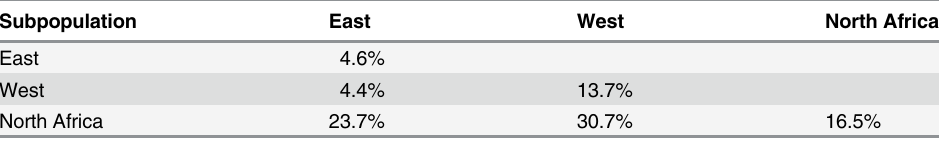
F ST (lower triangle) and F IS (diagonal) between and within the three subpopulations of P . kuhlii inferred by G ENELAND for fi ve microsatellite loci. The “ East ” and the “ West ” subpopulations correspond to the two European subpopulations (Fig 6) but do not refer to mtDNA